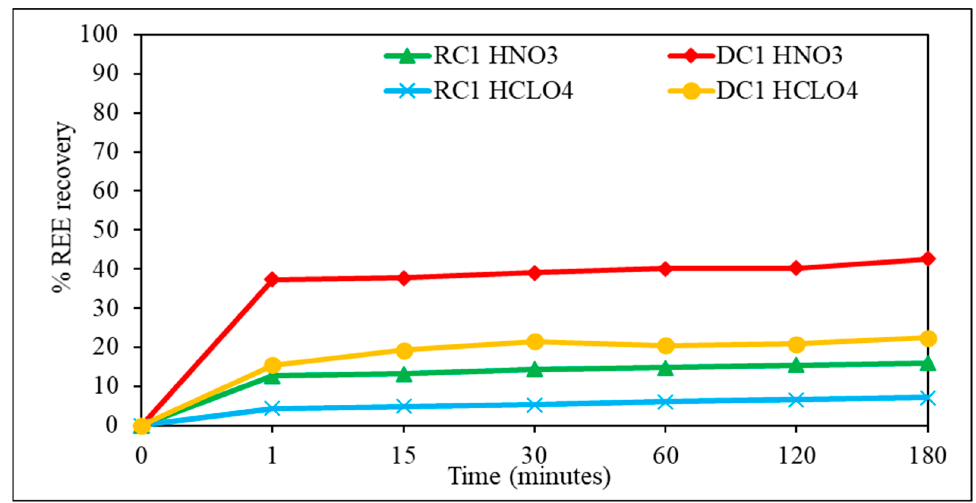
Figure 7. RC1 and DC1 % REE leaching recovery under the optimised leaching parameters (HClO 4 /HNO 3 concentration of 2 M, solid: liquid of 10 g/L, leaching temperature of 50 °C, D 90 = − 106 μ m, stirrer speed 550 rpm). D 90 = − 106 µ m, stirrer speed 550